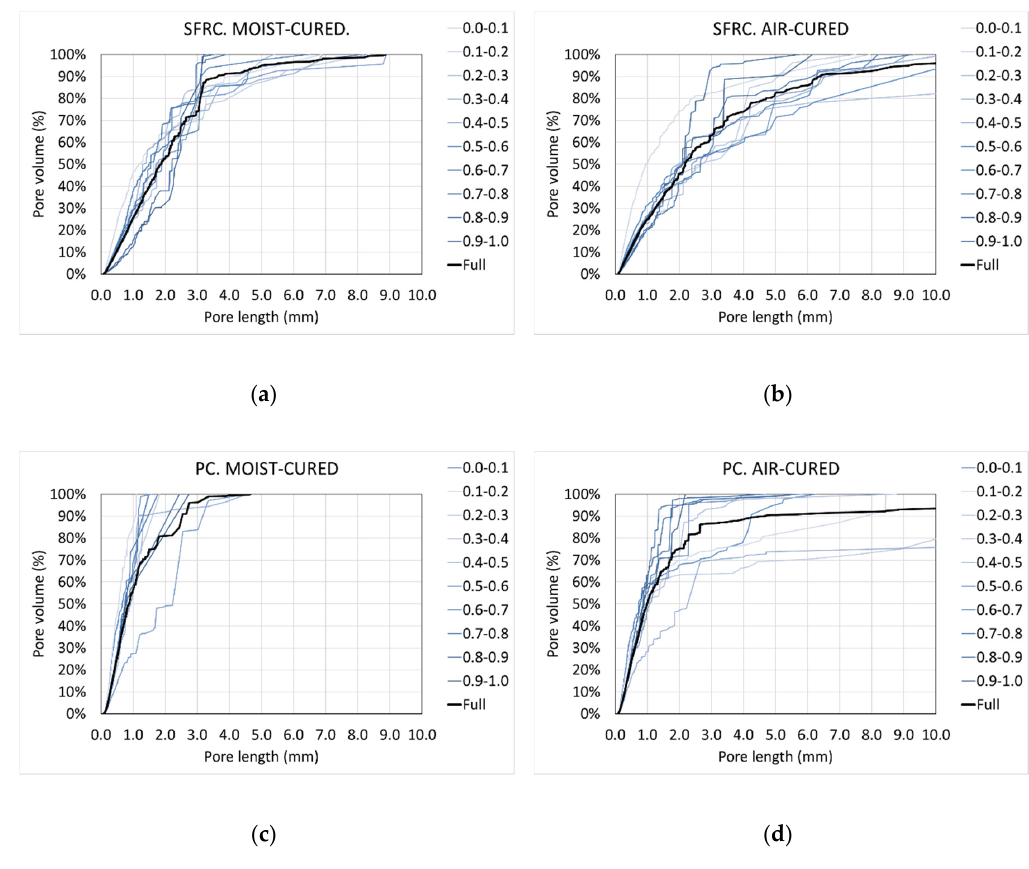
Figure 9. Porosimetric curves along the depth: ( a ) SFRC moist-cured, ( b ) SFRC air-cured, ( c ) PC moist-cured and ( d ) PC air-cured.